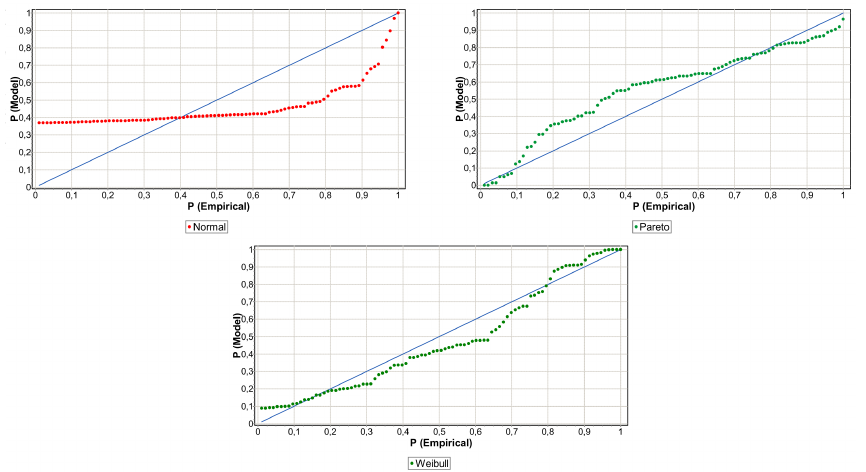
Figure 4. Clinical-risk P-P plots of severity distributions.